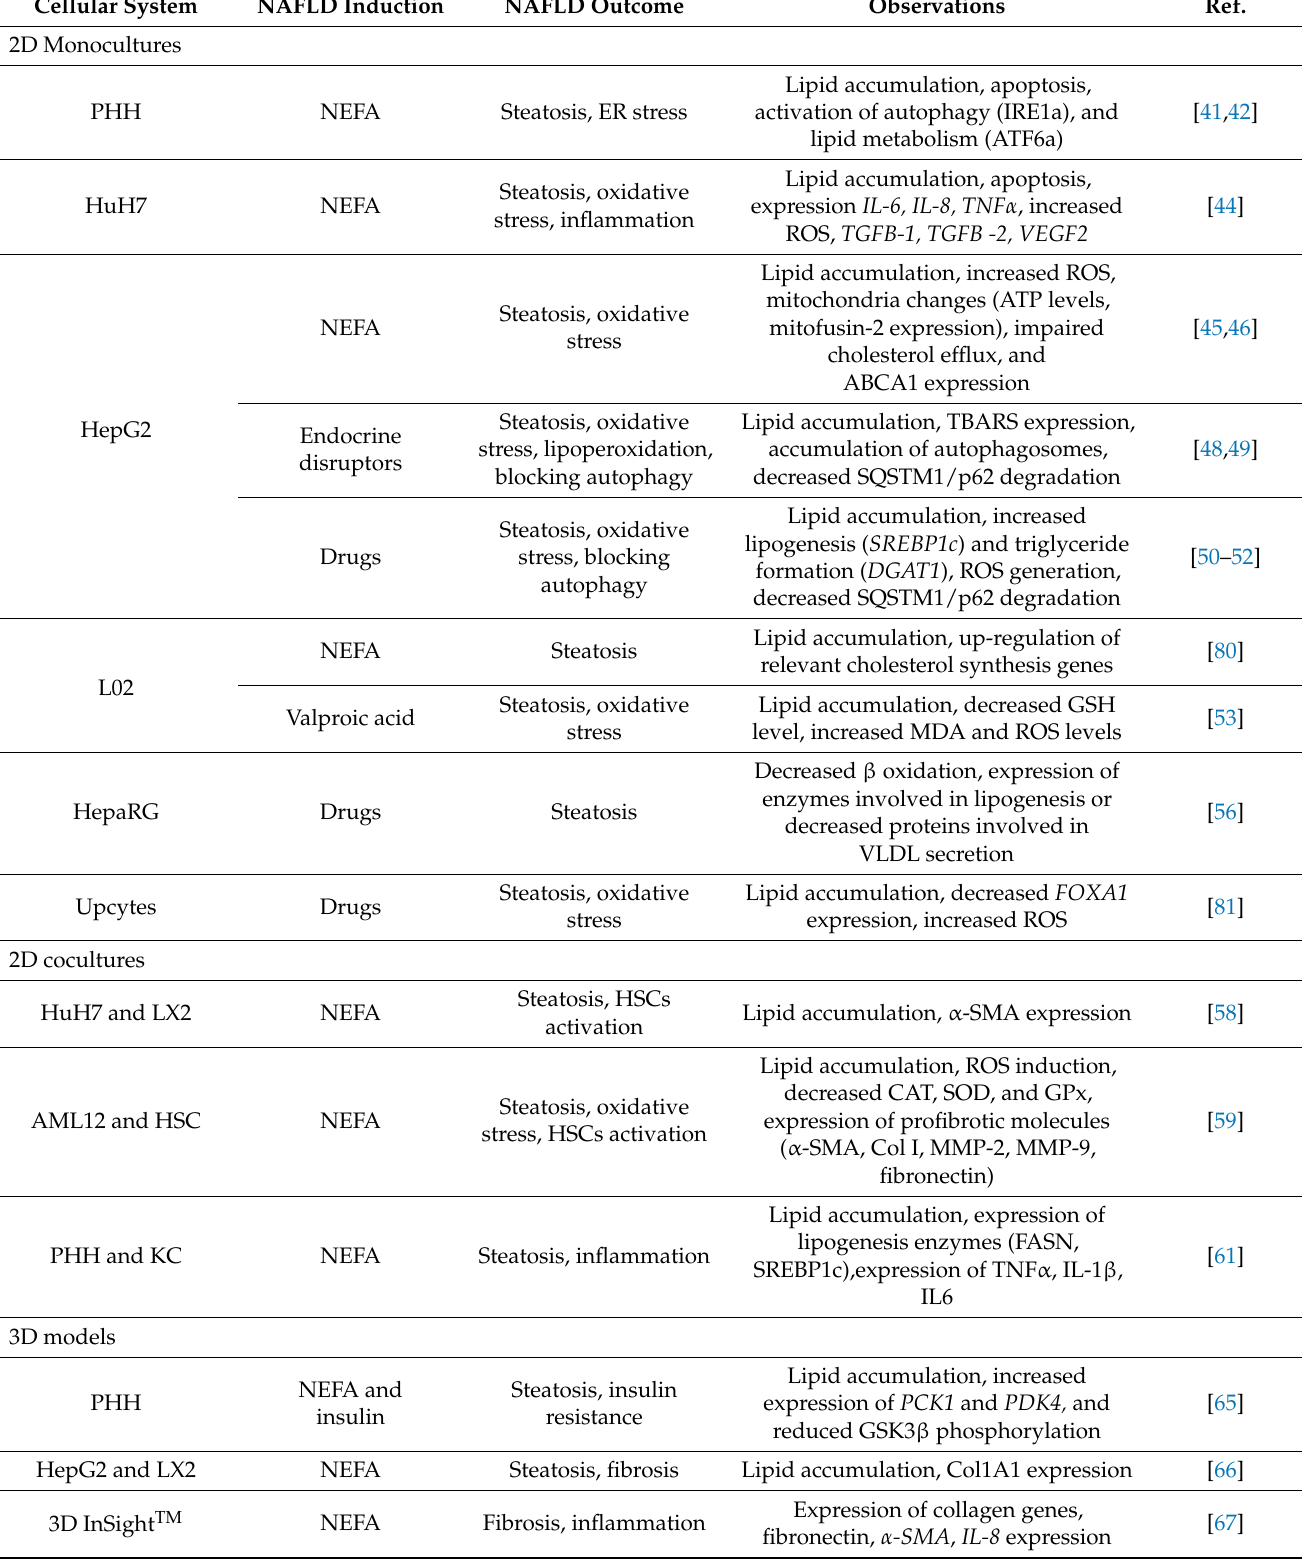
Table 1. Cellular models to study NAFLD in